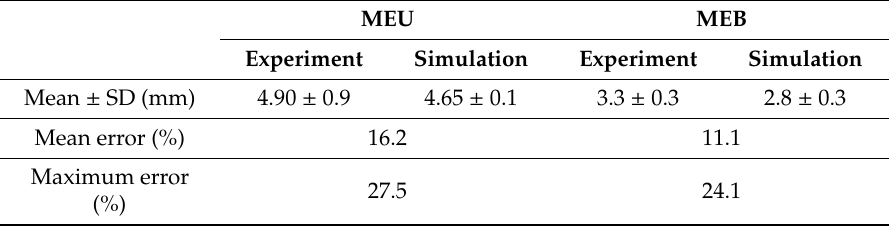
Figure 3. ( a ) Experimental validation of the study method. The left column demonstrates the experimental results recorded by the thermal imager. The right column demonstrates the simulation results from COMSOL Multiphysics. Both types of results were obtained at 10 s of radiofrequency catheter ablation (RFCA). Cases from the experiment were labeled with the captured maximum and minimum temperatures. The simulated minimum temperatures were bound by the temperature of the green zone in their respective experimental results to provide apparent characteristics of temperature distribution. ( b ) Definition of the maximum width ( W max ) of the heating of electrodes. W max is defined as the widest heat generated perpendicular to an electrode on the tissue surface at 10 s of RFCA. The black lines in the simulation result of the MEU mode represent the 50 °C isothermal Table 2. Comparison of W max from experiment and simulation at 10 s of contour. Table 2. Comparison of W max from experiment and simulation at 10 s of RFCA.